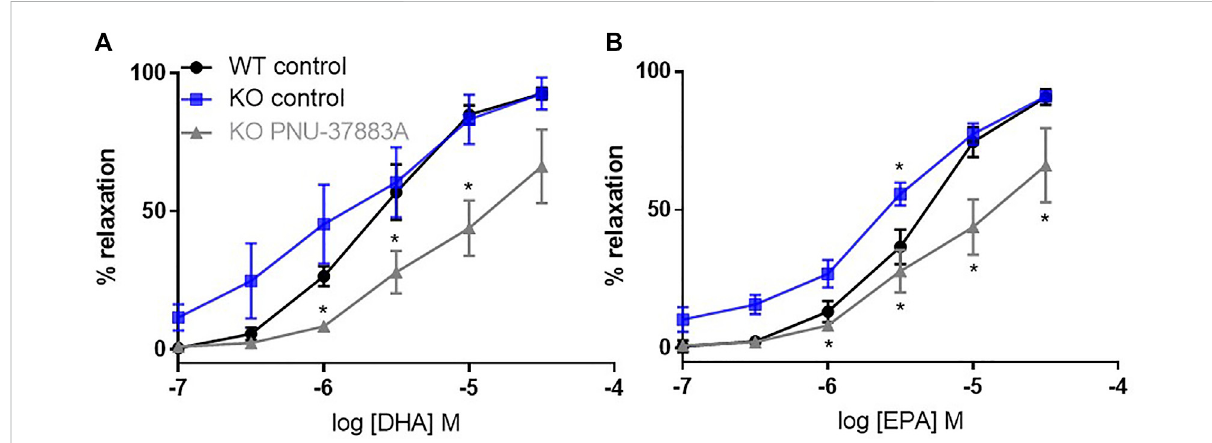
FIGURE 4 TheeffectsofinhibitionofK ATP channelsonn-3PUFA-inducedrelaxationinKir6.1KOmouseaorticringspreconstrictedwithU46619. (A) DHA- and (B) EPA-induced relaxation in Kir6.1 KO mouse aorta following treatment with the K ATP inhibitor PNU-37883A (3 µm) compared with untreated rings from the same animal. n = 5, data represented as mean ± SEM. * p < 0.05, signi fi cant difference from control curve assessed by 2-way ANOVA followed by Bonferroni multiple comparison